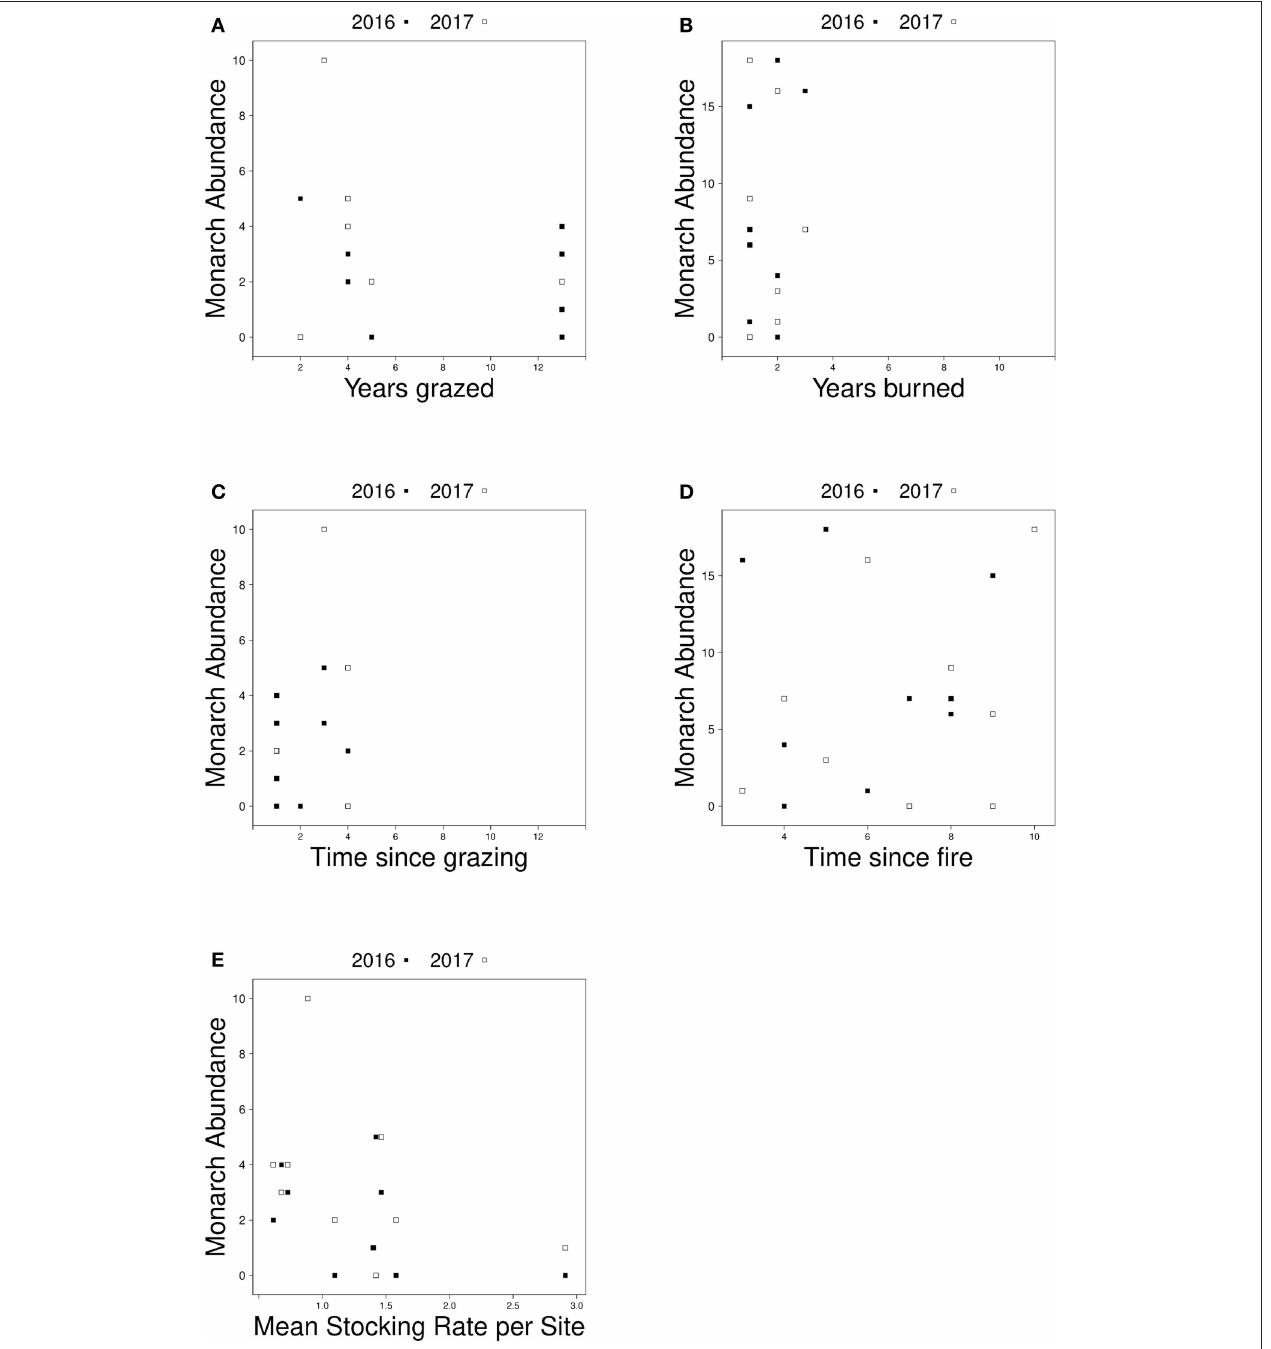
FIGURE 4 | Relationship between monarch abundance and (A) the number of years grazed sites were grazed from 2005 to 2017, (B) the number of years burned sites were burned from 2005 to 2017, (C) the number of years since grazing management took place at grazed sites, (D) the number of years since fire management took place at burned sites, and (E) the average stocking rate at grazed sites in 2016 (black squares) and 2017 (white